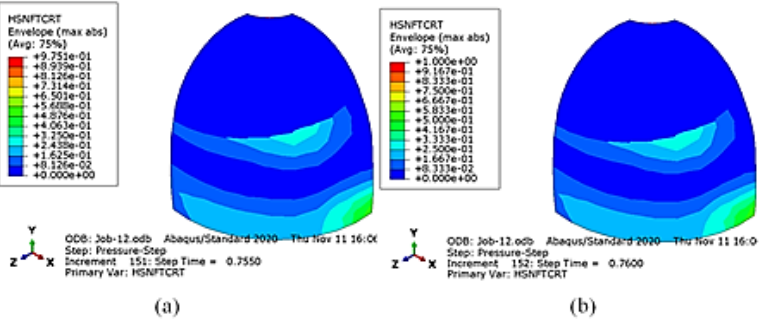
Figure 13. Hashin fiber tension failure index (HSNFTCRT): ( a ) lower than 1 at load step 0.755, and ( b ) greater than 1 at load step 0.76.